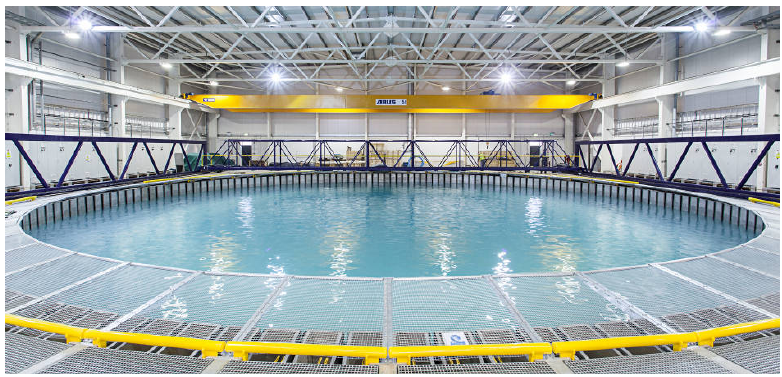
Figure 2. The FloWave Ocean Energy Research